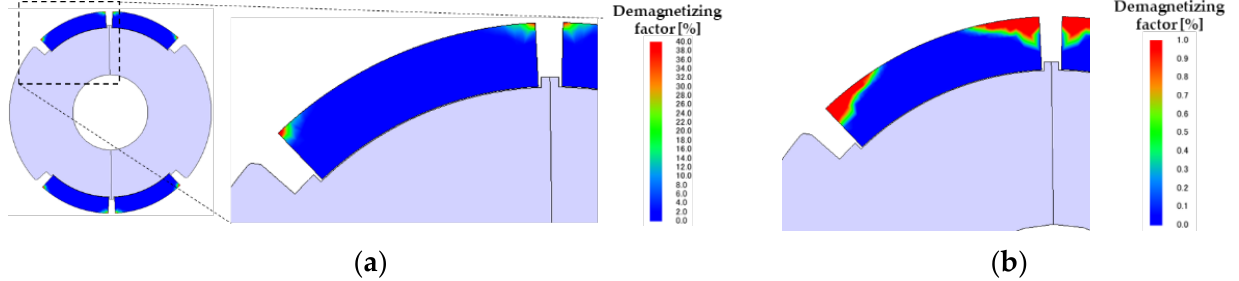
Figure 24. Contour diagram of the demagnetizing factor: ( a ) maximum range is 40%; ( b ) maximum range is 1%.